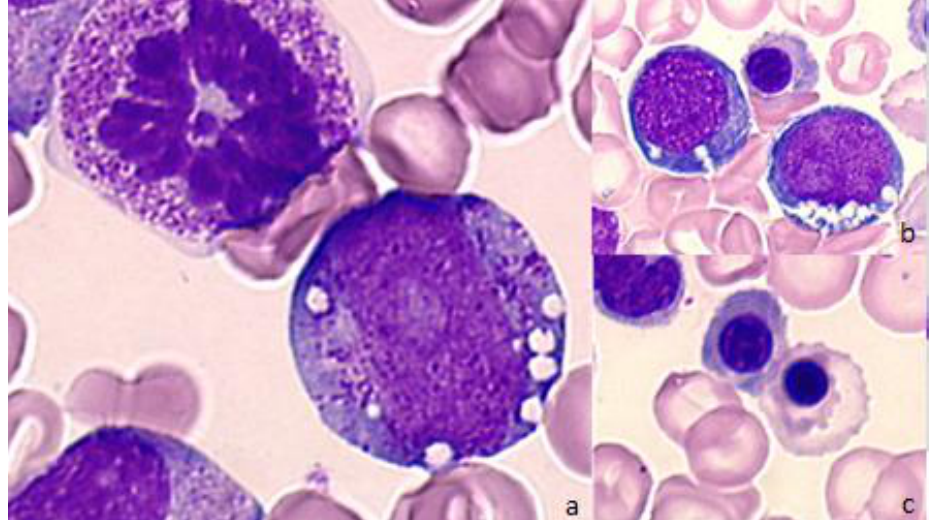
Figure 3. Representative bone marrow smears from a patient with Pearson syndrome. ( a ) Bone mar- row smear showing vacuolation of a myeloid precursor. May-Grünwald-Giemsa (MGG), magnifi- cation ×1000. ( b ) Bone marrow smear showing vacuolation of acidophilic and basophilic erythro- blasts. MGG, magnification ×500. ( c ) Bone marrow smear showing acidophilic erythroblasts with laminated cytoplasm, magnification ×500.